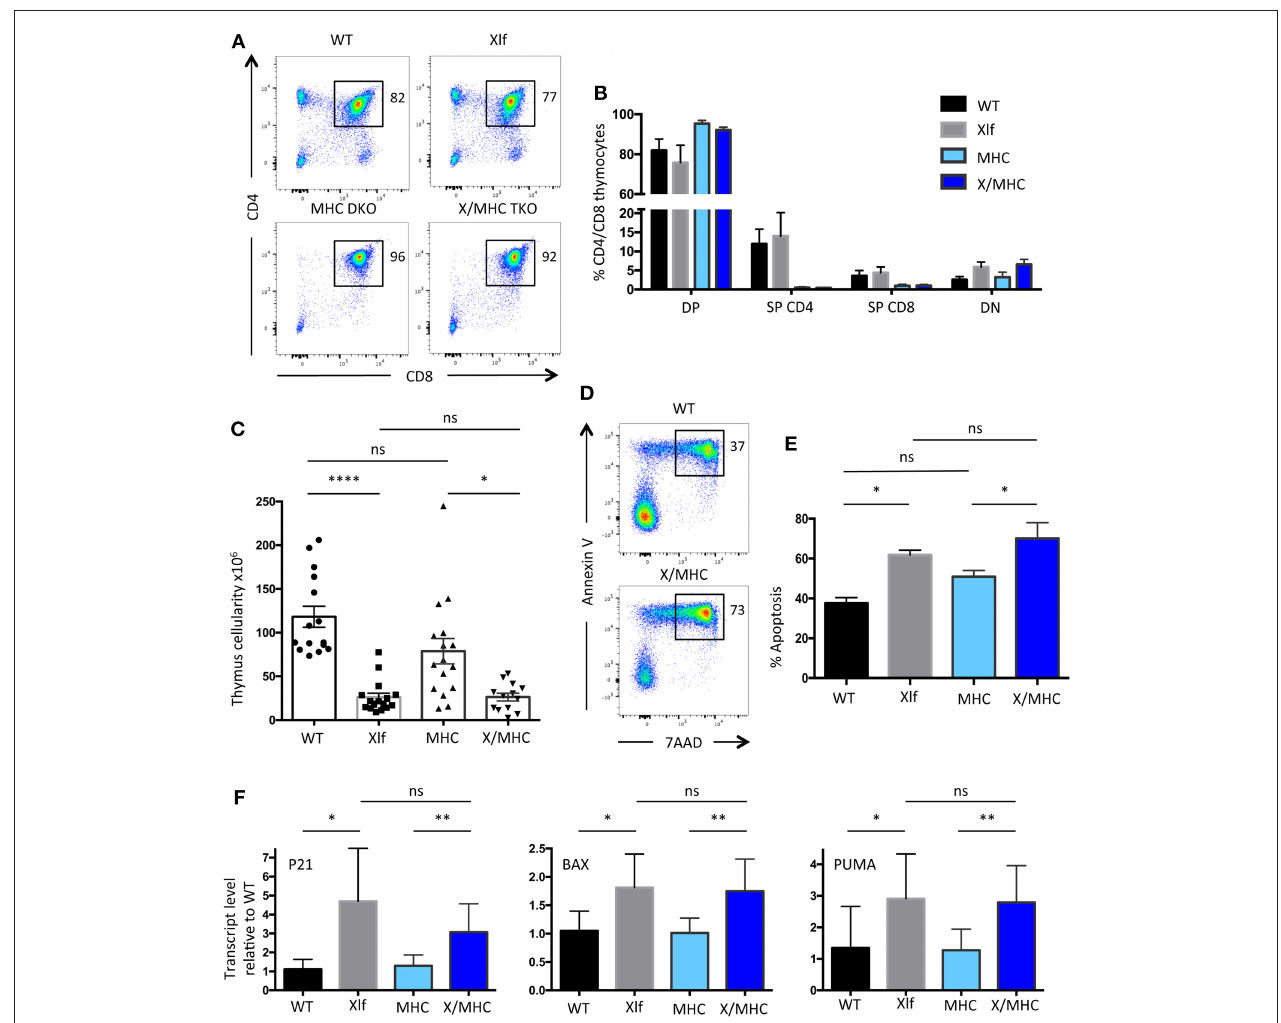
FIGURE 1 | Xlf − / − immune phenotype is not related to positive selection at the DP stage in the thymus. (A) Immunostaining of CD4/CD8 in thymii of WT, Xlf − / − (Xlf), MHC class I − / − MHC class II − / − (MHC DKO), Xlf − / − MHC class I − / − MHC class II − / − (X/MHC TKO) mice. (B) Quantification of CD4/CD8 thymic populations. (C) Total thymocyte numbers. (D) Thymocyte apoptosis analyzed by Annexin V/7AAD staining following 20h of culture. (E) Quantification of thymocyte apoptosis after 20h of culture. (F) Quantitative RT-PCR analysis of P53 target genes P21, BAX, and PUMA in thymocyte freshly extracted RNA. P-values were calculated using non-parametric Kruskall-Wallis with Dunn’s correction tests (C,E) and non-parametric Mann-Whitney tests (F)